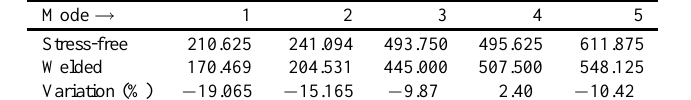
Table 1 Values of the natural frequencies of the plate in stress-free and welded